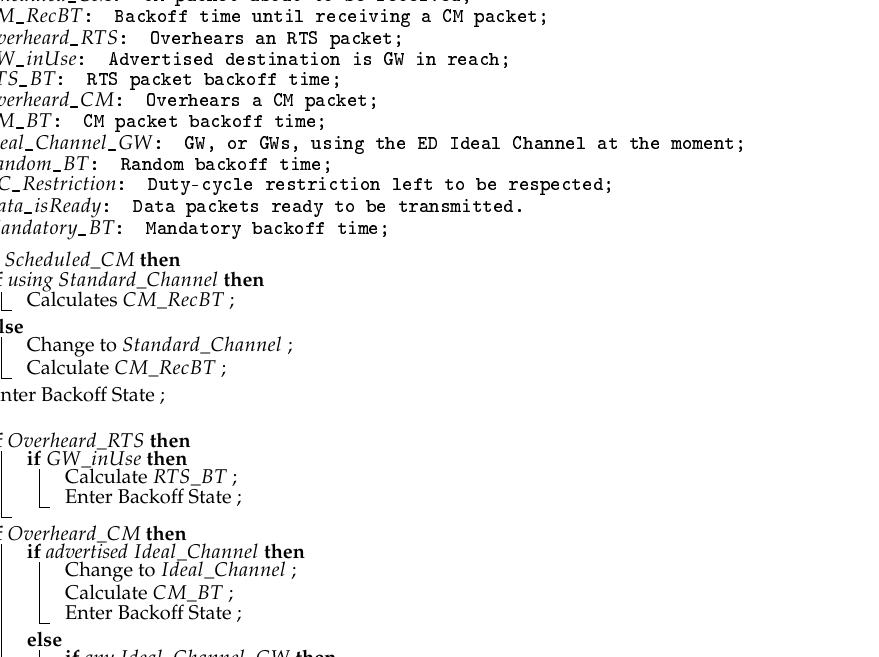
Algorithm 2: LoRa channel hopping protocol: ED idle state execution